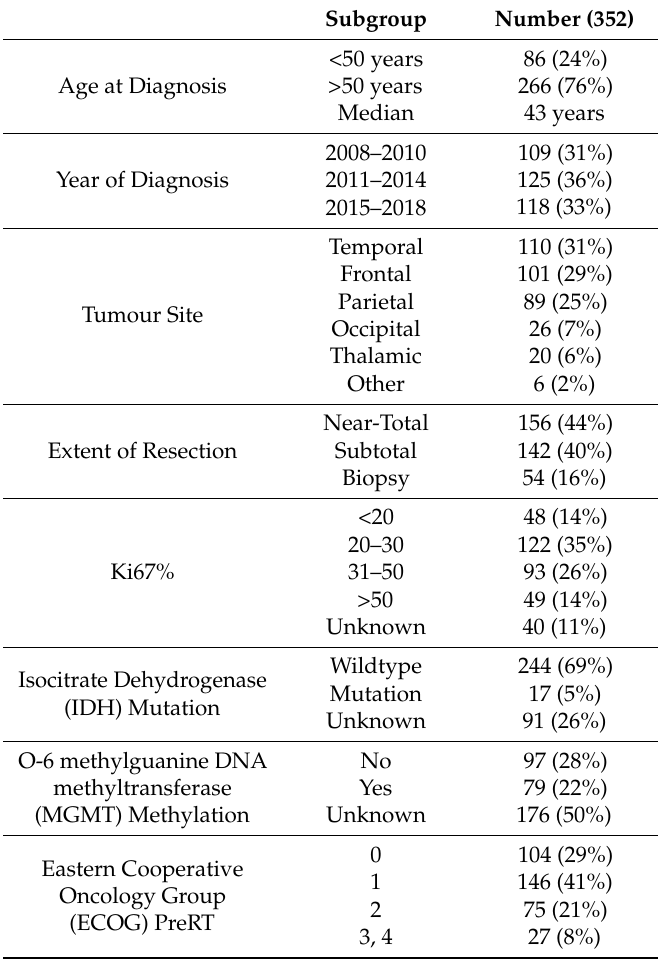
Table 1. Patient and treatment